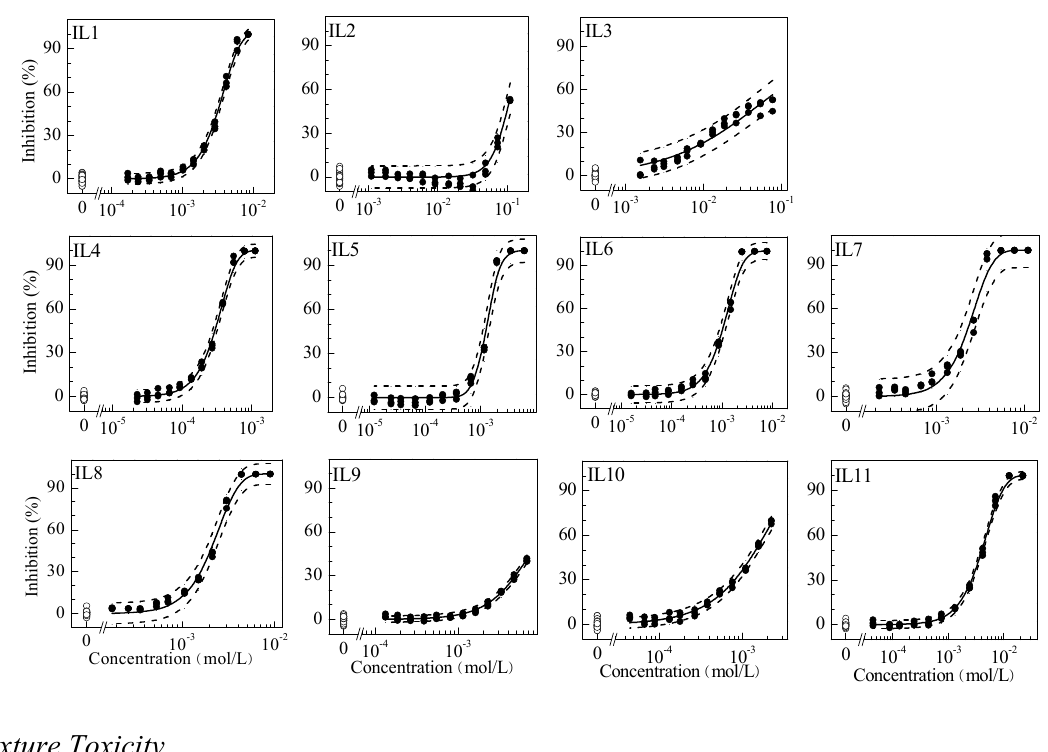
Figure 1. Concentration–response curves for the inhibitory effects of individual ionic liquids on luciferase luminescence. Hollow circle: blank control; solid circle: data observed; solid line: model fit; dash line: confidence